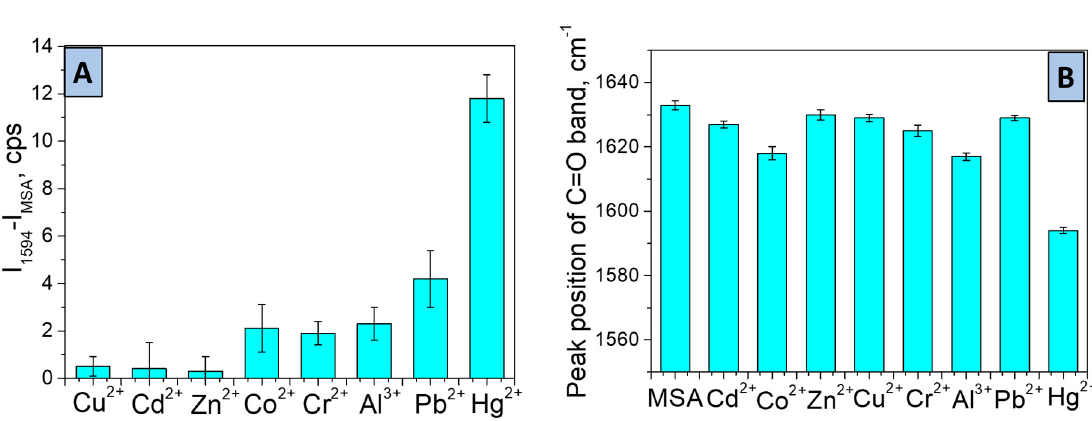
Figure 7. Selectivity tests: ( A ) peak intensity difference for Au-MSA (IMSA) and their metal ion complexes (I 1594 ); ( B ) metal-ion induced a frequency shift of the carbonyl group of the SERS sensor. Conditions: initial metal ion concentration = 10 -8 M.